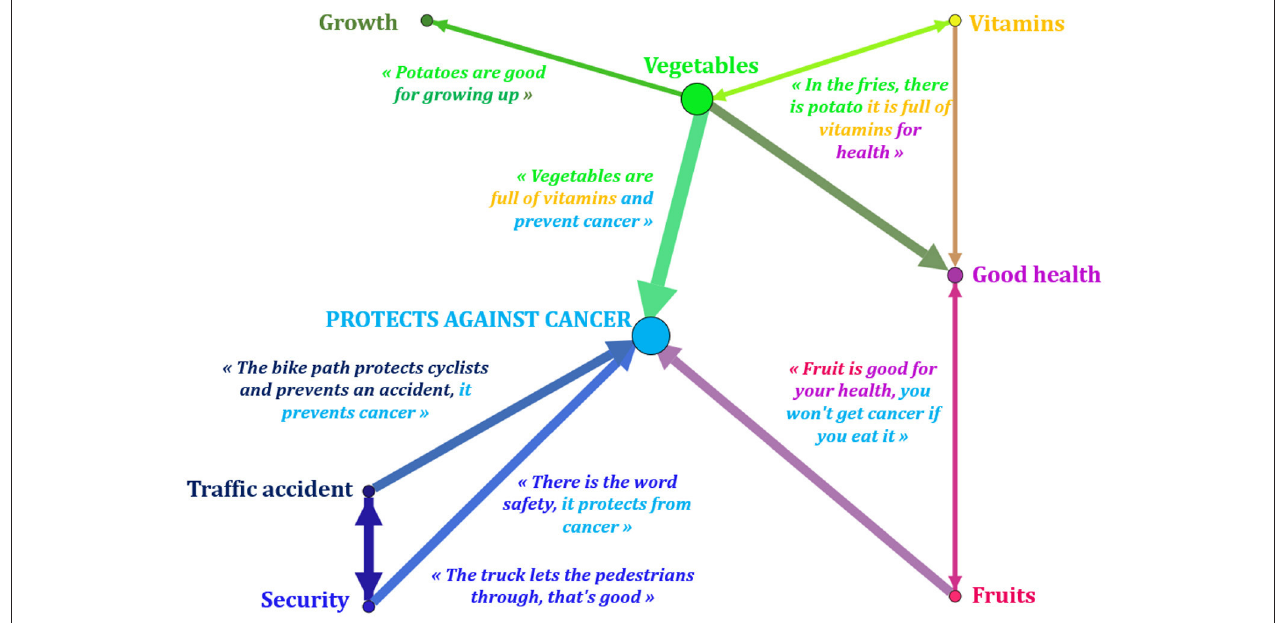
FIGURE 5 | Pictorial representation of complex conceptions systems Photonarration ≪ protects against cancer ≫ - GEPHI 9.2 © (GUCE19F). The conceptions reveal more or less important links depending on the thickness of the line between different determinants favorable to health. Example: “vegetables”; “Vitamins”; “Growth”: these determinants are associated with each other, the child highlights their link and their causal effect: vegetables are full of vitamins, help to grow taller and protect against cancer.